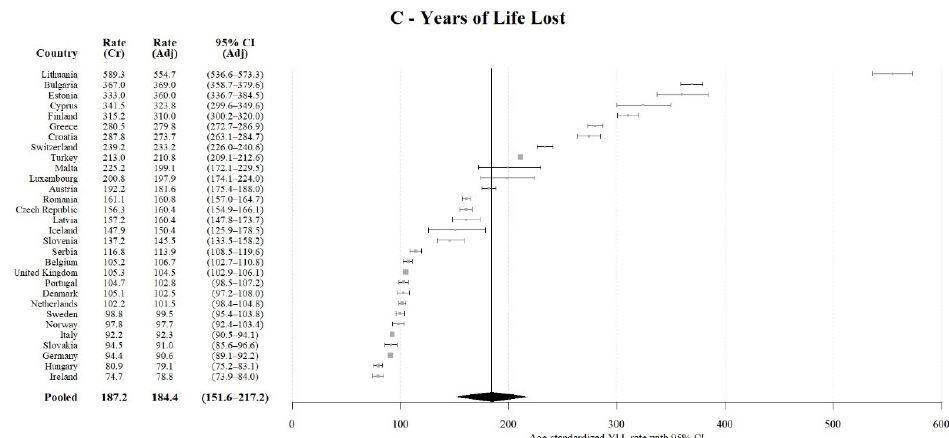
Figure 3. Crude and age-standardized rates of TBI-related hospital discharges ( A ), deaths ( B ) and YLLs ( C ) with estimated pooled rates for the 30 analyzed European countries in 2014.